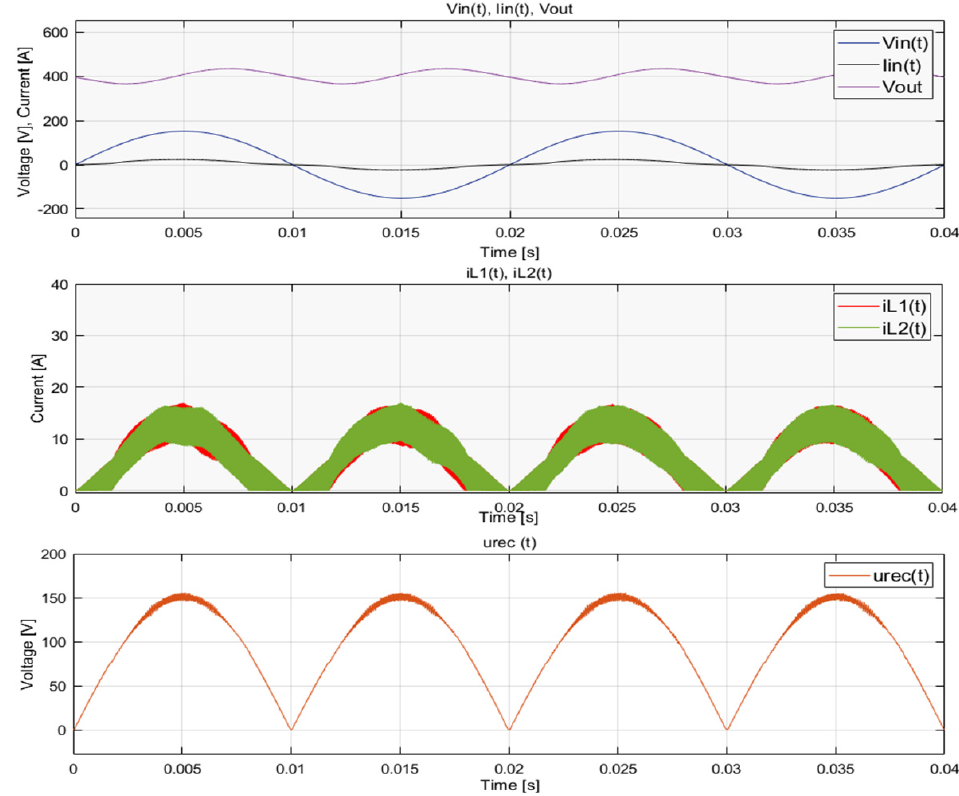
Figure 7. Low—frequency waveforms representation of the input voltage (Vin), input current (Iin), output voltage (V out ), inductor L 1 and L 2 currents (iL 1 , iL 2 ) and the input rectified voltage (Vrec).